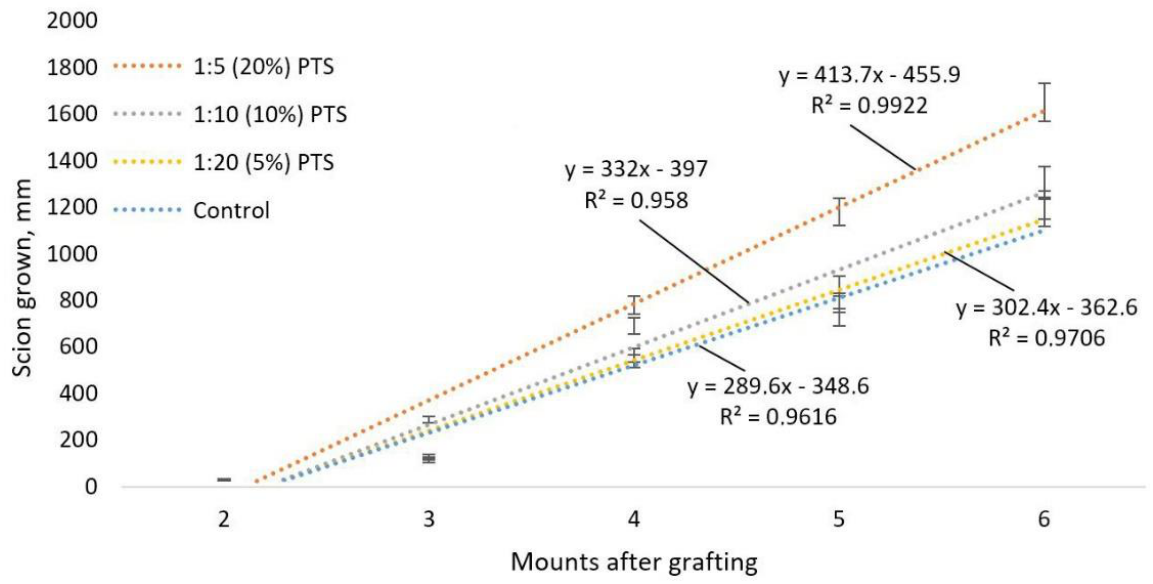
Figure 9. The dynamics of growth of cherry seedlings of the “Revna” variety within 4 months after planting in the greenhouse with indirect processing using PTS diluted in DW in three proportions (1:5 (20%), 1:10 (10%) and 1:20 (5%)).